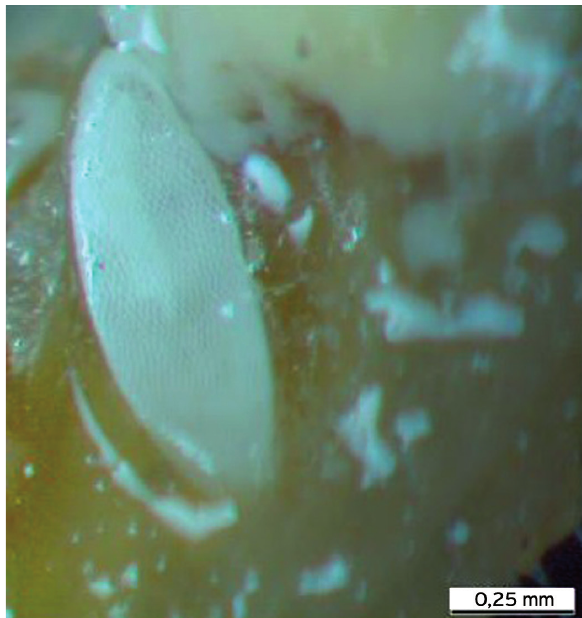
Figura 6. Morfologia do ovo de Neosilba perezi em vista ao microscópio estereoscópio.